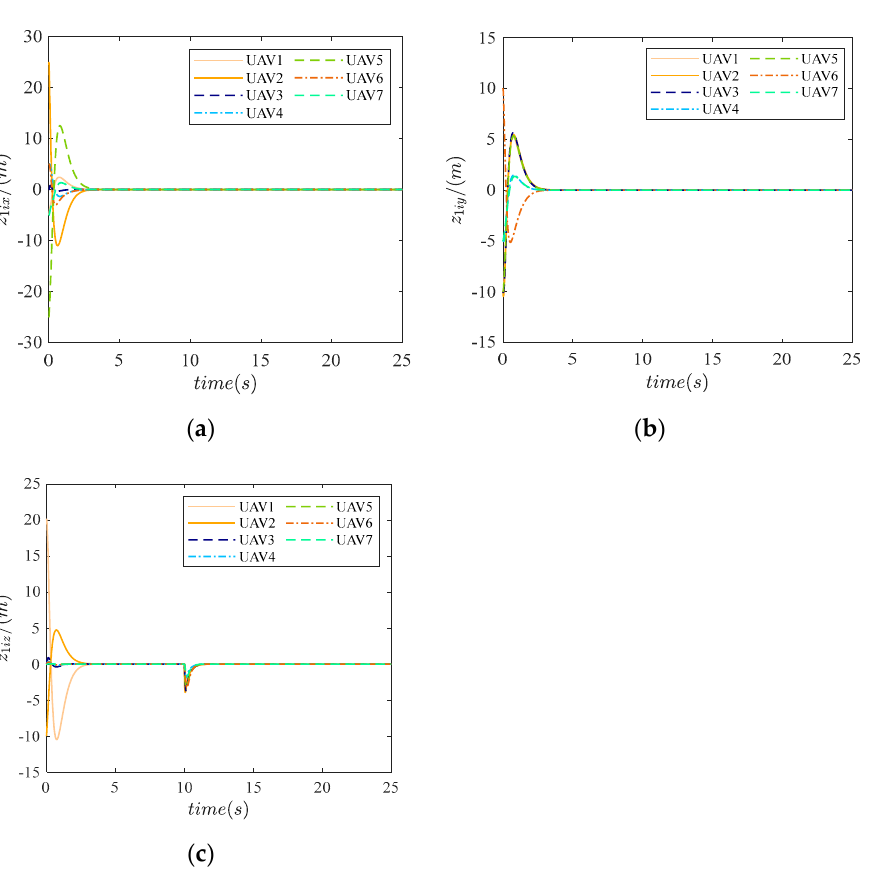
Figure 8. UAV position tracking error curves: ( a ) x-direction variation curve; ( b ) y-direction variation curve; ( c ) z-direction variation curve.